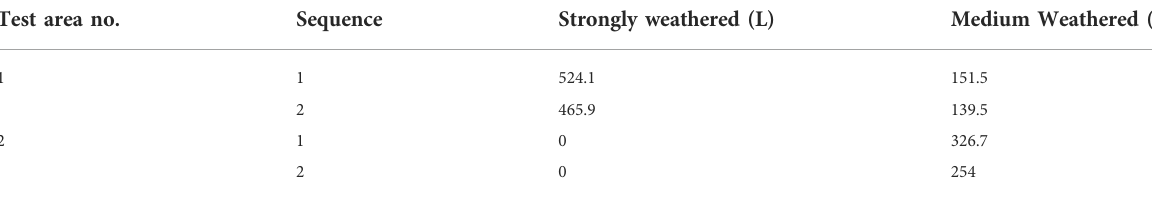
TABLE 5 The average grout take of 1-m depth in the different weathered formations. Test area no.